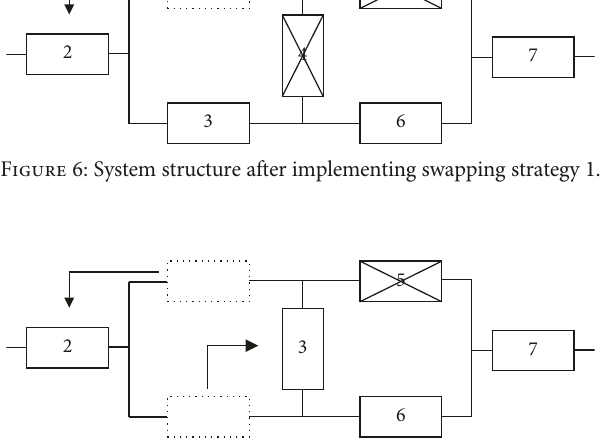
Figure 7: System structure after implementing swapping strategy 3.